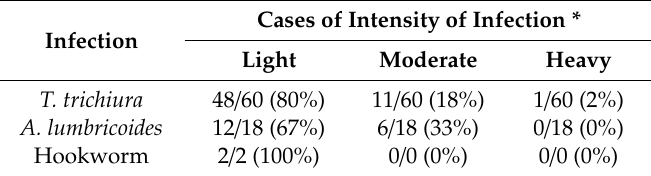
Table 3. Cases with light, moderate or heavy soil-transmitted helminth (STH) infections among infected children ( n = 65). Cases of Intensity of Infection * Infection Light